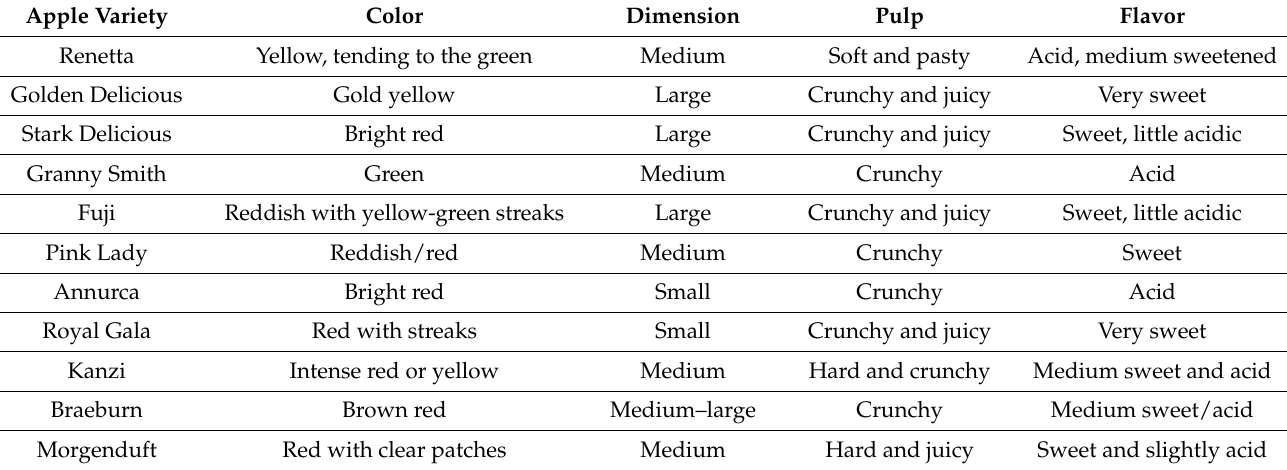
Table 1. Qualitative, physical and organoleptic parameters characterizing all the existing apple fruit varieties. Apple Variety Color Dimension Pulp Flavor